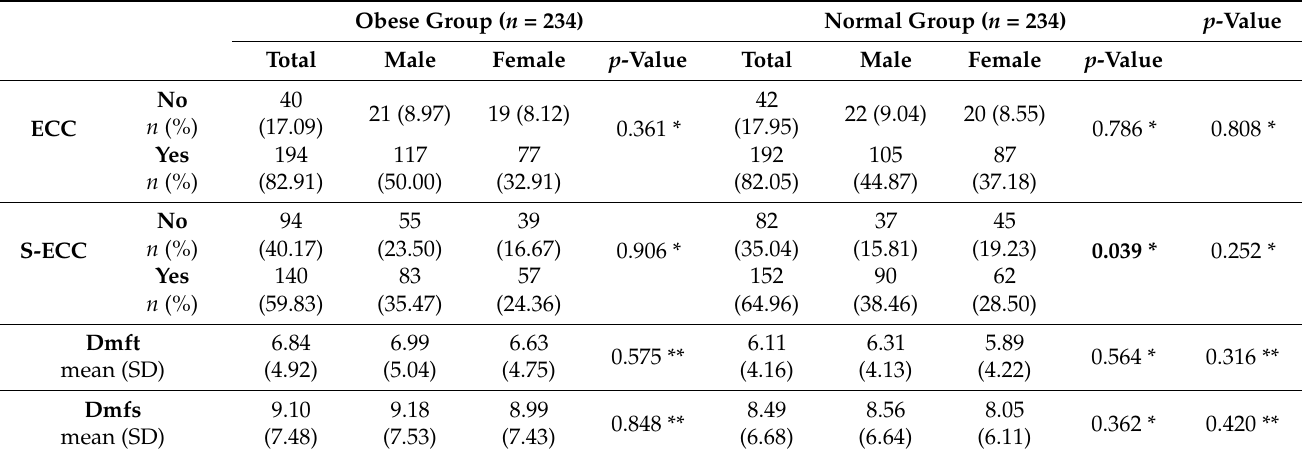
Table 1. Caries status in the study